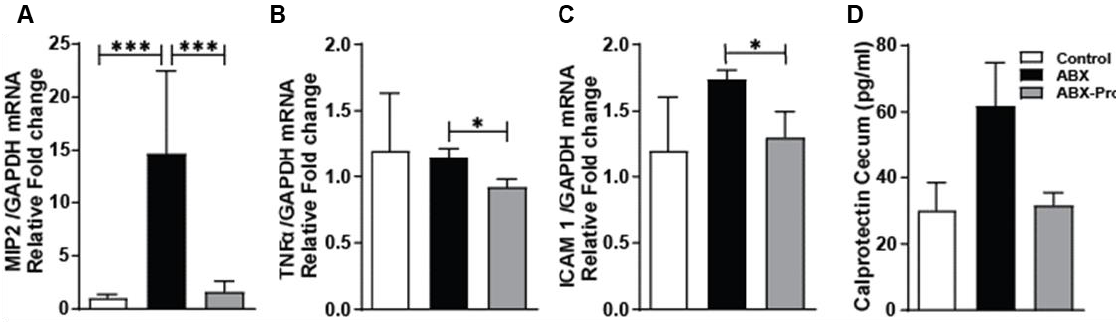
Figure 8. Intestinal Inflammation. Mice were treated as described in Fig1. At euthanasia, proximal colon was dissected and relative expression of ( A ) MIP2, ( B ) TNFα , and ( C ) ICAM1 mRNA was detected by qRT-PCR. Cecum was dissected and ( D ) cecal content was used to measure calprotectin by ELISA. Values represent mean ± standard error of the mean. * p < 0.05, *** p < 0.001.